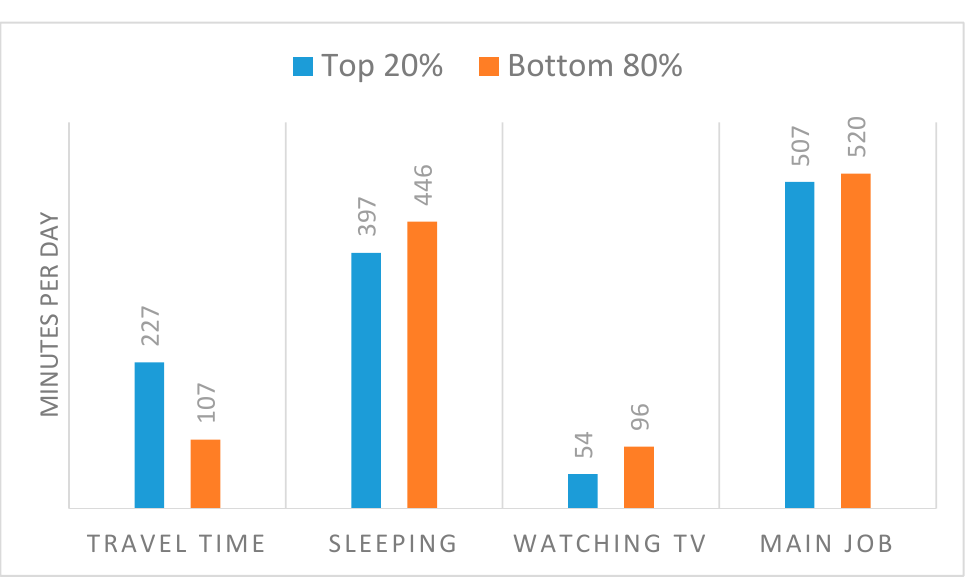
Figure 3. Workers riding public transit: Average total time spent in a workday on select activities—top 20% travel time (Long transit commuters) against bottom 80% travel time counterpart.